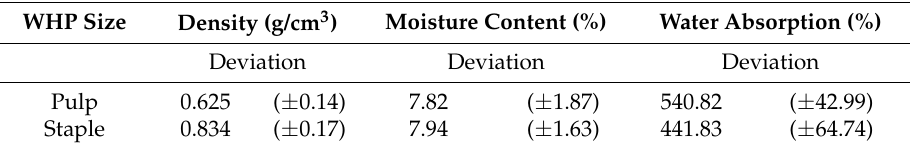
Table 1. Physical characterization of WH petiole (WHP).